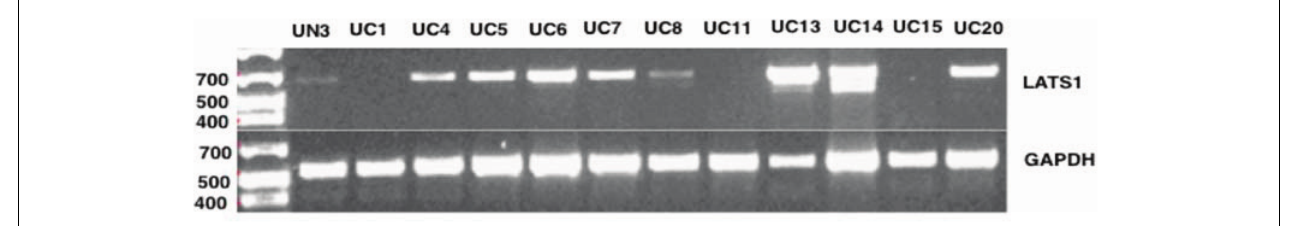
FIGURE 2 | LATS1 expressions analysis using PCR. LATS1 expression was examined in urinary bladder cancer tissues (UC), peritumoral urinary bladder (UN). UC6 did not contain any SNP in the LATS1 gene. UC7 showed SNP at 41736; UC14 harbors SNP at 35366; UC1 has SNPs/variants at 16045, 34614, 35366, 41625, 41736, and 56177; UC4 has SNPs/variants at 34614, 35366, 41625, and 41736; UC5 has SNPs/variants at 34614, 41625, 41736, and 42029; UC8 has SNPs/variants at 35366, 41625, 41736, 42029, and 56177;